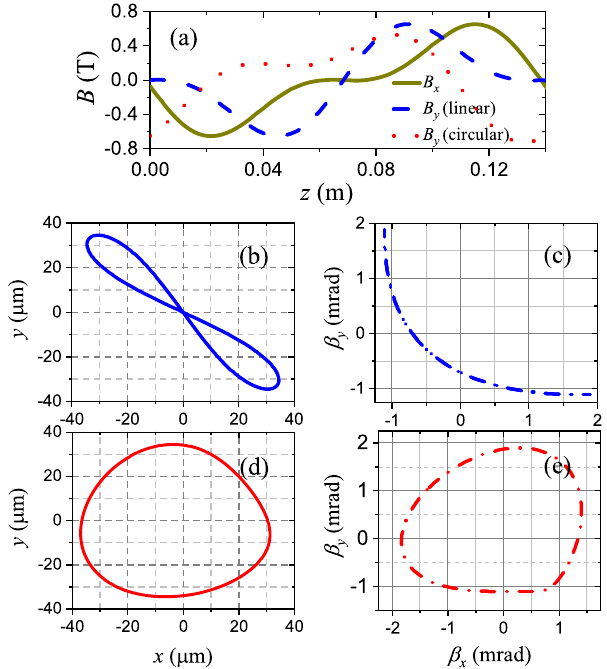
FIG. 4. The magnetic fields (a) of the linear and circular mode in the Fig. 8 AMPU, with the corresponding electron orbits (b), (d) and velocities (c), (e). The blue lines (b), (c) are corresponding to the 135° linear mode and the red lines (d), (e) are correspond- ing to the right-hand circular mode,